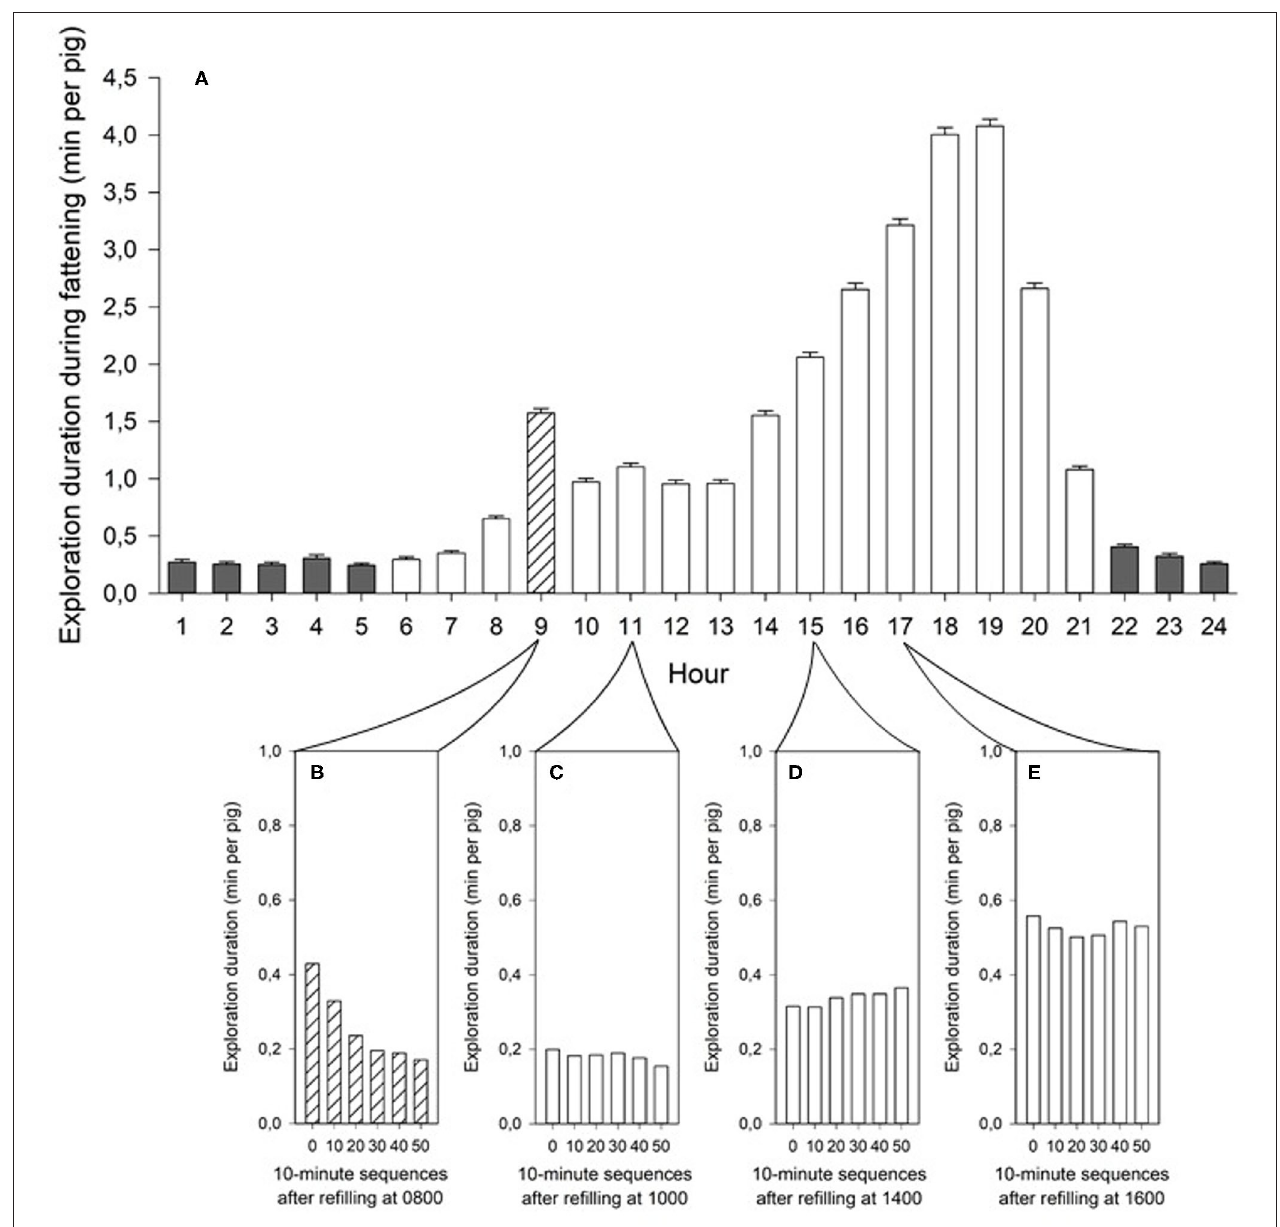
FIGURE 5 | (A) Diurnal pattern of exploration duration (mean ± SE minutes per pig) at the dispenser filled with chopped straw in treatment R1 (one additional offer of chopped straw at 0800) during fattening. (B) Exploration durations in 10-min sequences within the hour after refilling the rooting area (striped bars). (C–E) Exploration durations within the hours at which in treatment R4 (see Figure 6 ) chopped straw was additionally offered. Light bars indicate light phase and dark bars indicate dark